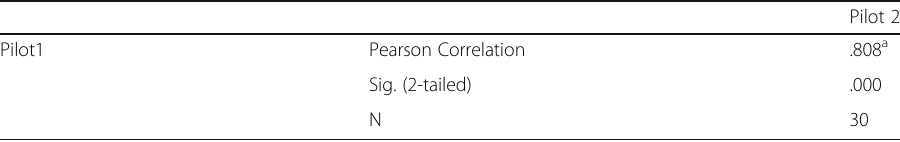
Table 1 Results of Pearson Correlation